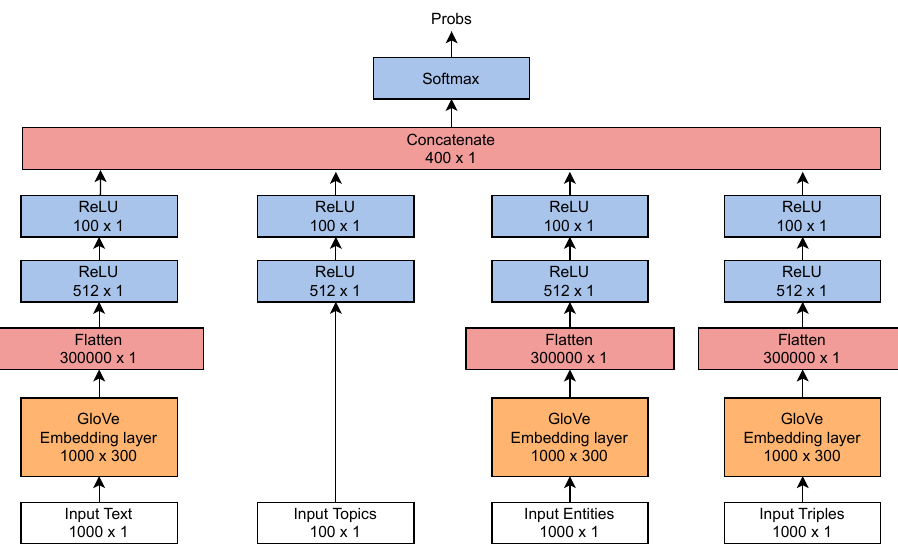
Figure 3. A deep learning architecture for the classification of news-feeds using raw text, topics, named entities, and